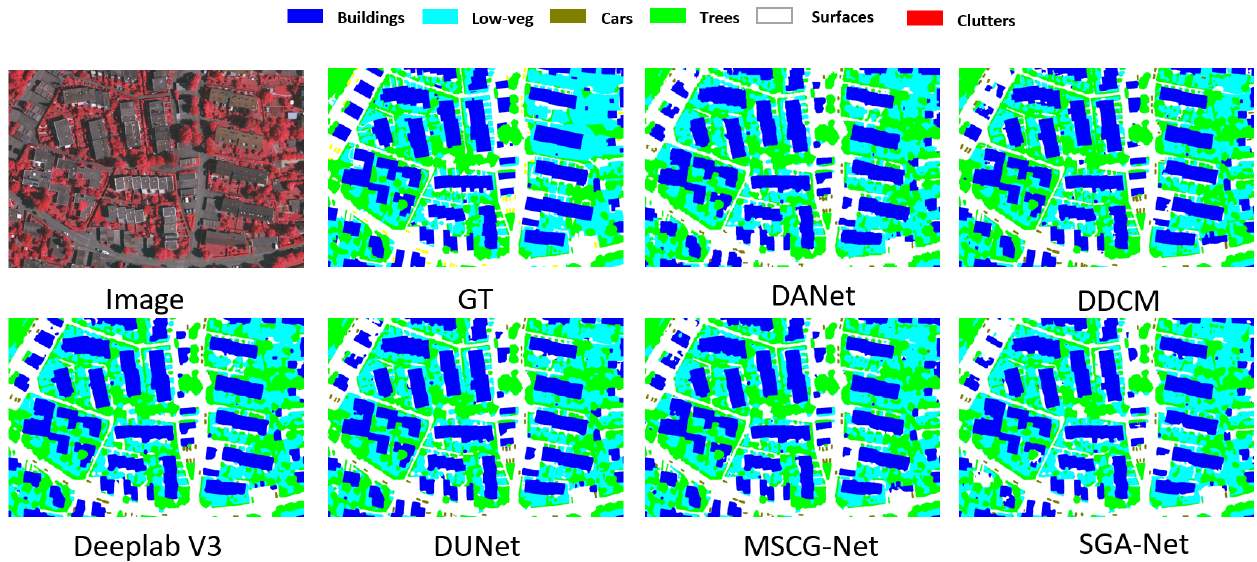
Figure 5. Visualization of tile35 in the Vaihingen